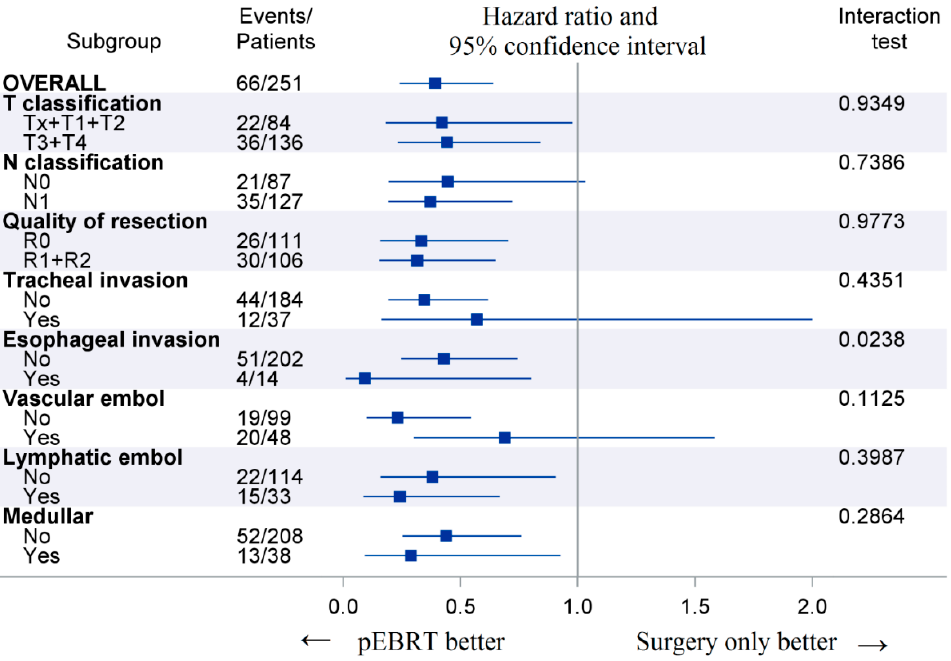
Figure 1. ( a ) Cumulative incidence of locoregional failure according to postoperative external beam